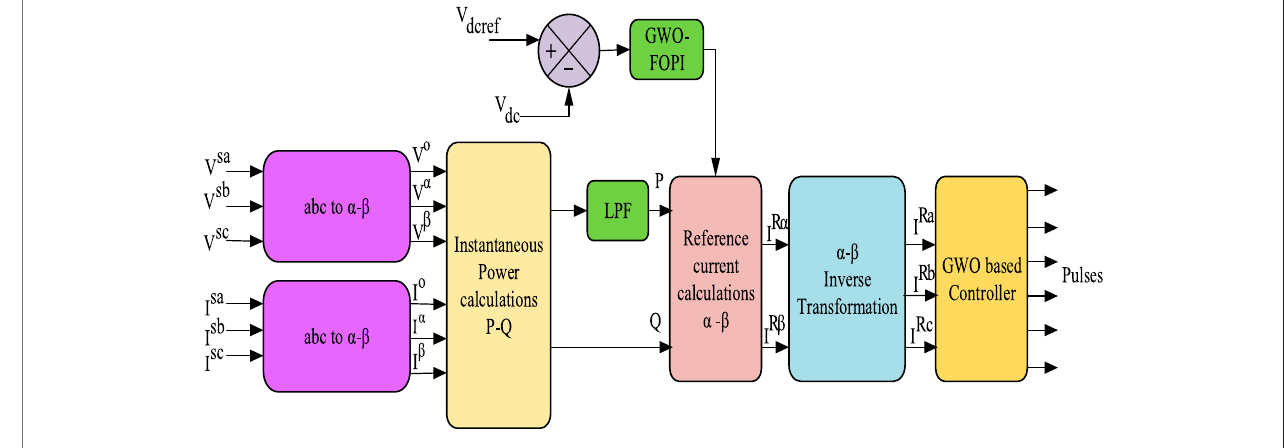
FIGURE 7 | HSHAPF control